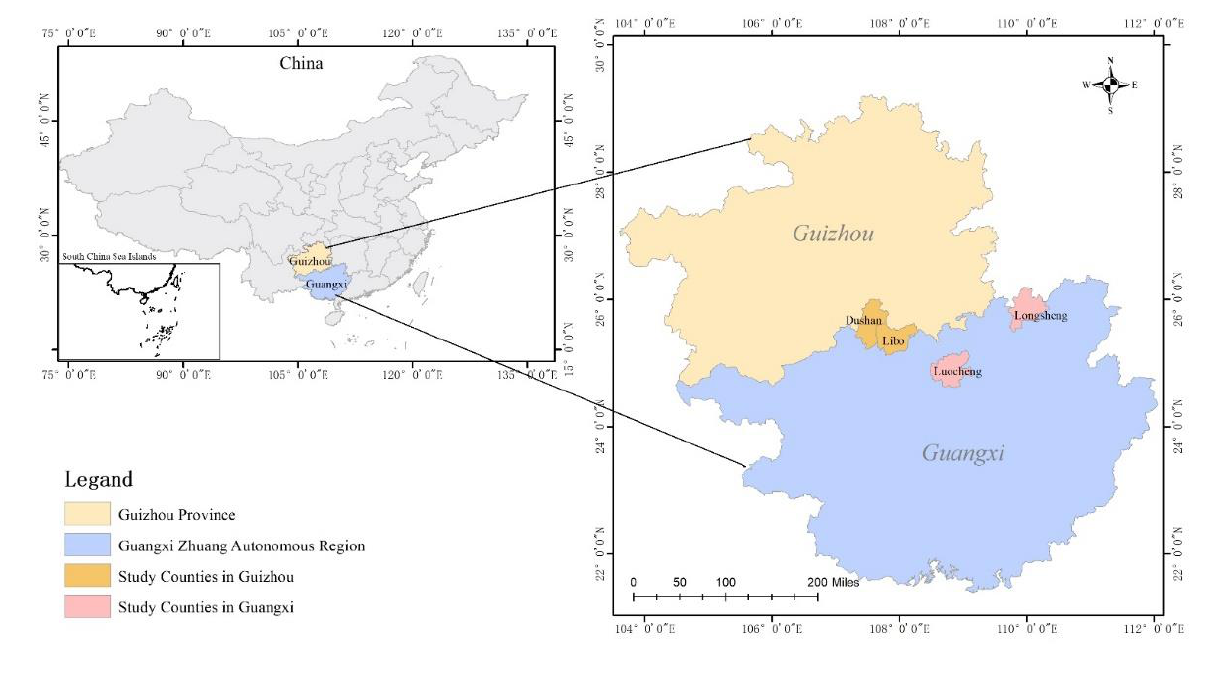
Figure 1. Location of the study area.